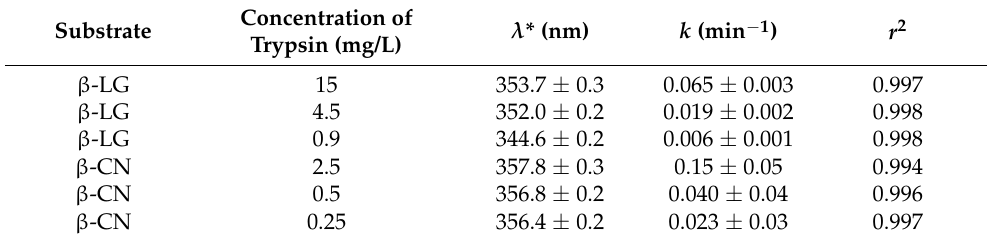
Table 1. Fitting of fluorescence data with Equation (11).